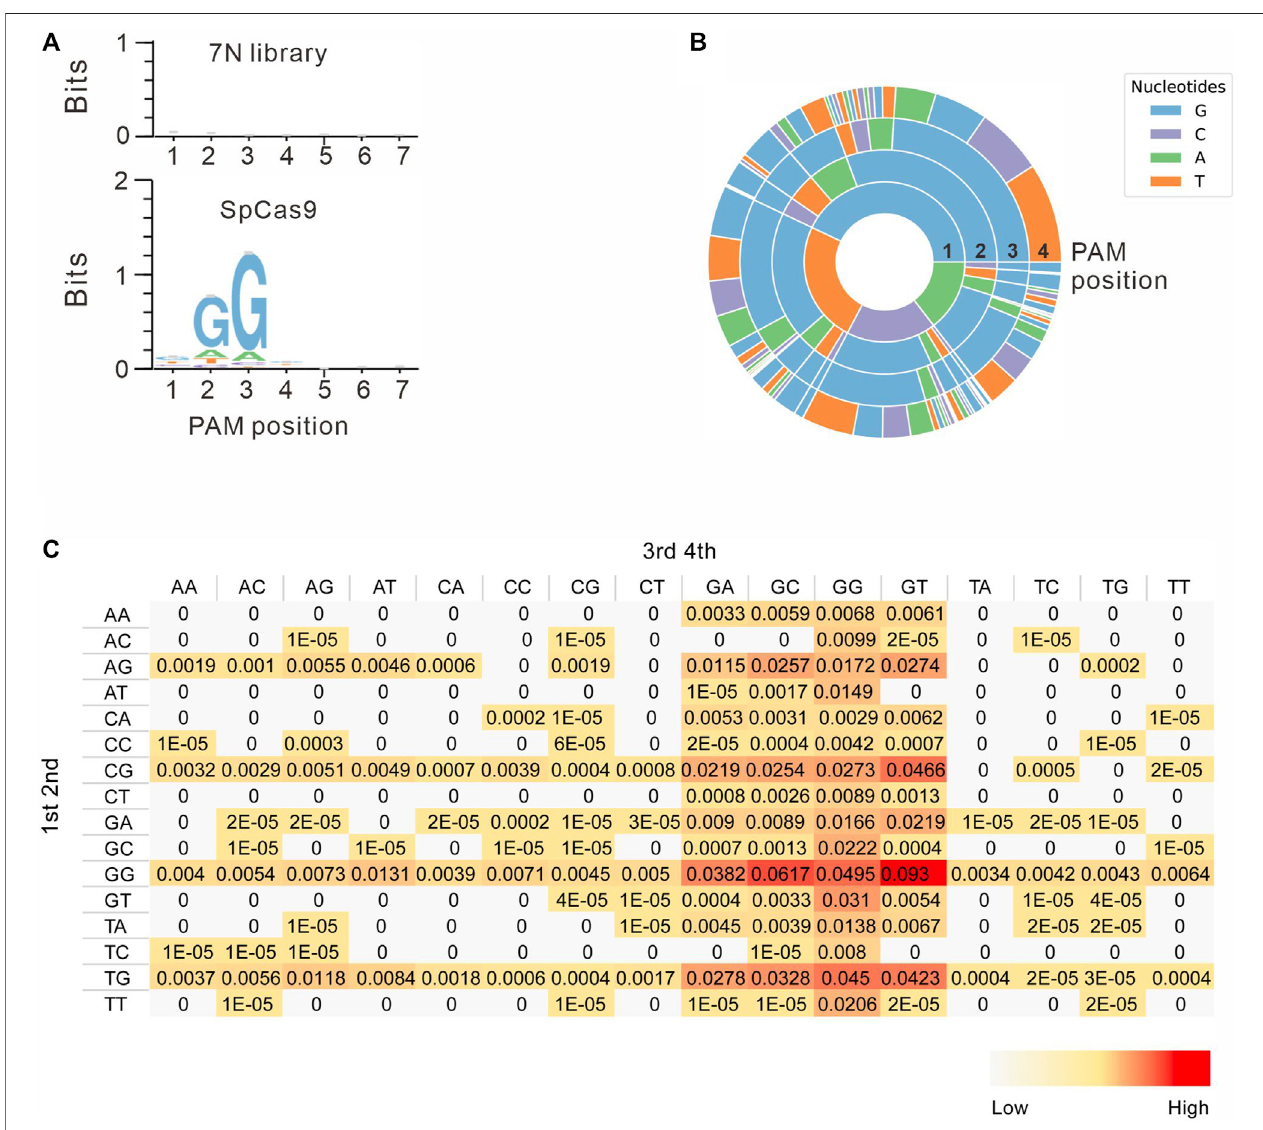
FIGURE 3 | PAM sequence analysis. (A) WebLogo is generated based on the PAM screening assay. The upper panel is the control cells without genome editing. the lower panel is the cells after genome editing. (B) PAM wheel is generated based on the PAM screening assay. (C) Heat map for ef fi ciency ratio of top all 256 PAMs. The 1 – 2 PAM sequences are shown on the left, and the 3 – 4 PAM sequences are shown on the top.